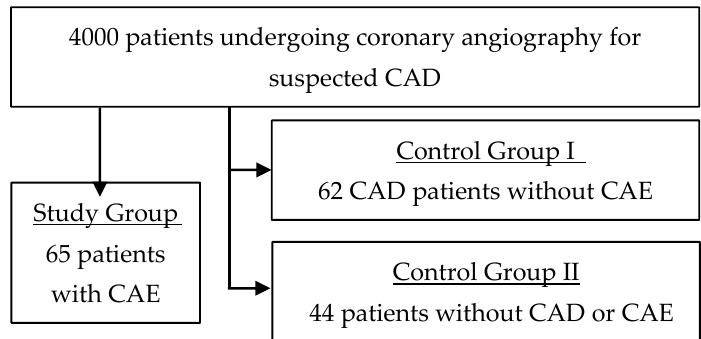
Figure 1. Cohort study flowchart. CAE, coronary artery ectasia. CAD, coronary artery disease.